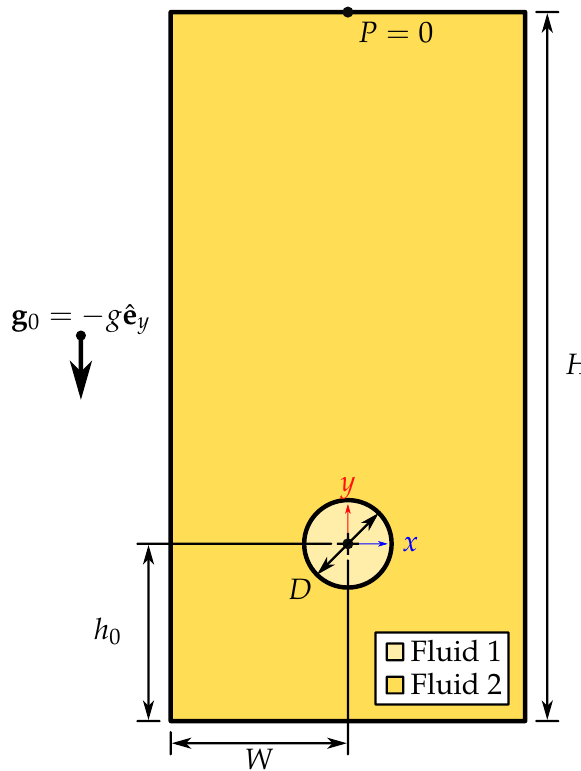
Figure 7. Schematic description of the rising bubble case.